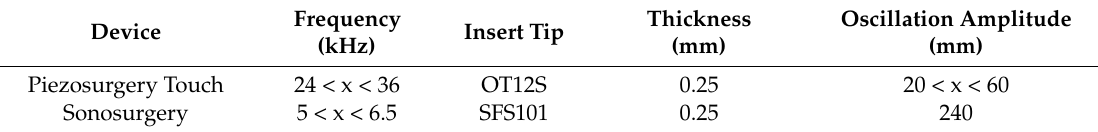
Table 2. Features of tips as reported by